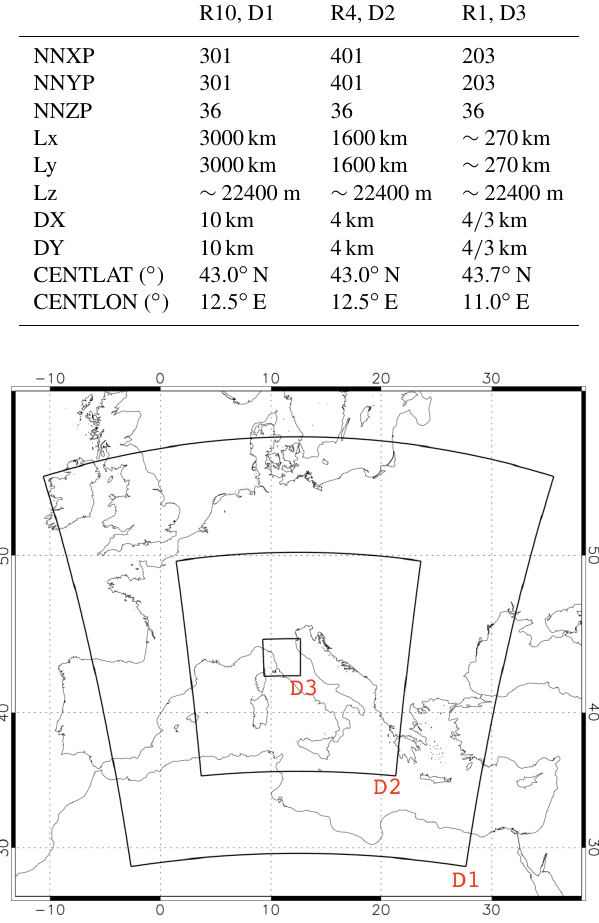
Figure 11. The three domains used in RAMS@ISAC. The model grid over domain D1 has 301 grid points in the NS and WE direc- tions and has 10km horizontal resolution; the model grid over do- main D2 has 401 grid points in the NS and WE directions and has 4km horizontal resolution. The model grid over domain D3 has 203 grid points in the NS and WE directions and has 4 / 3km horizontal resolution. All grids have the same 36 vertical levels spanning the 0–22.4km vertical